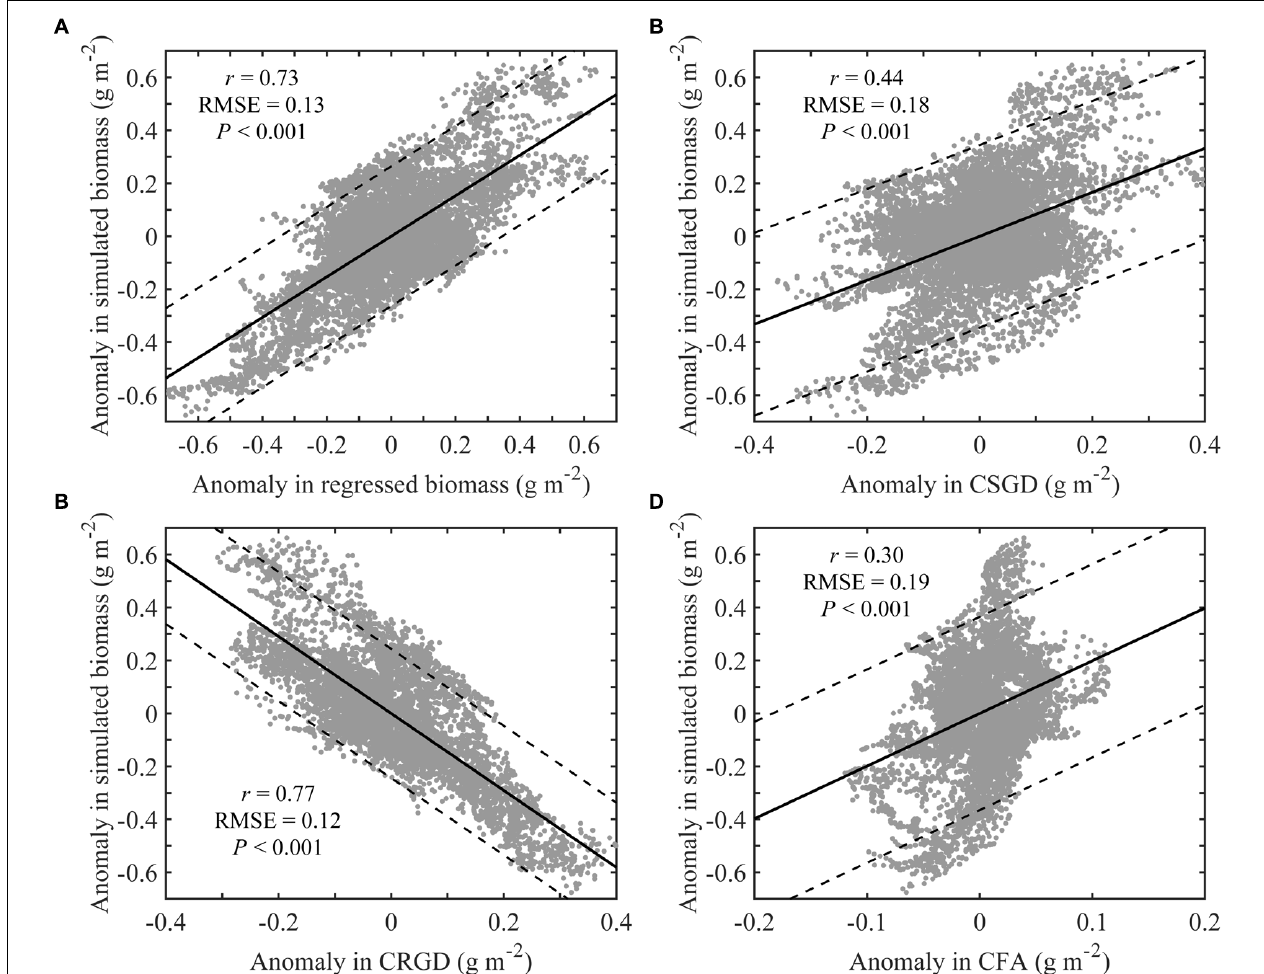
FIGURE 9 | Correlation of the anomalies in simulated biomass and regressed biomass (A) ; CSGD (B) ; CRGD (C) ; and CFA (D) for the Yesso scallop ( P. yessoensis ) in the Changhai sea area, China. The black lines show regressed lines and the black solid line is the 95% confidence